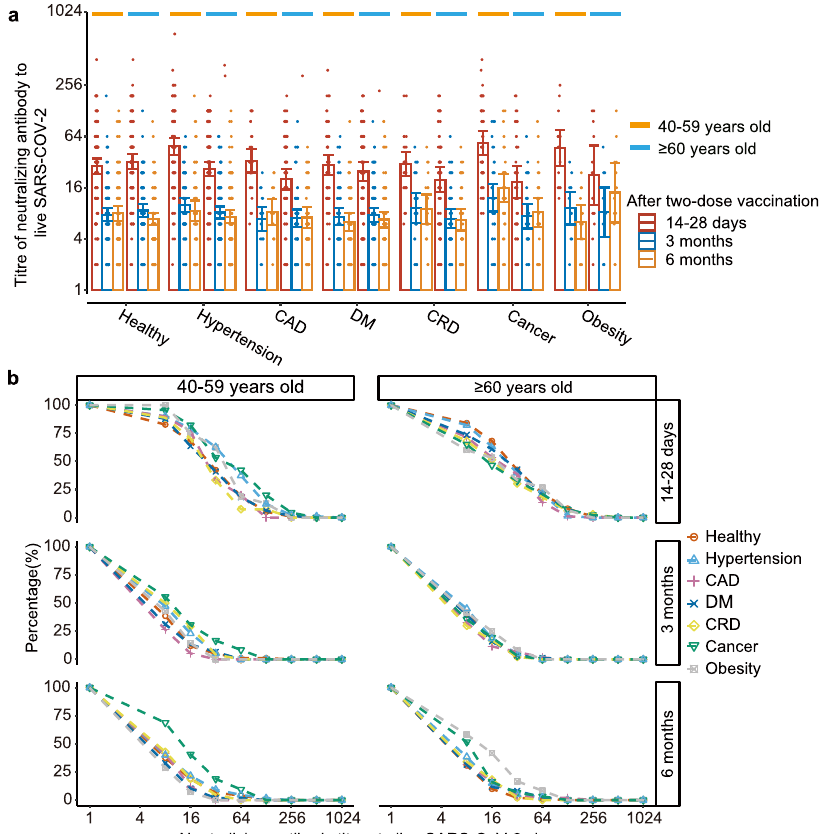
Fig. 3 Neutralizing antibodies to live SARS-CoV-2 virus (wild type) induced 14 – 28 days, 90 days, and 180 days after two-dose CoronaVac. n = 969 study participants. The error bars represent the standard error of the experiment results. a Titers of neutralizing antibodies across age groups. red- , blue- and orange-color refer to 14 – 28 days, 3 months and 6months after two-dose vaccination, respectively. Orange line refer to 40 – 59 years old group, and blue line refer to senior group older than 60 years old. b The inverse cumulative distribution of neutralizing antibodies in hypertension (light blue triangle), CAD (pink plus), DM (blue cross), CRD (yellow rhombus), cancer (green triangle), obesity (gray square) subgroups, and healthy control (red circle), across age